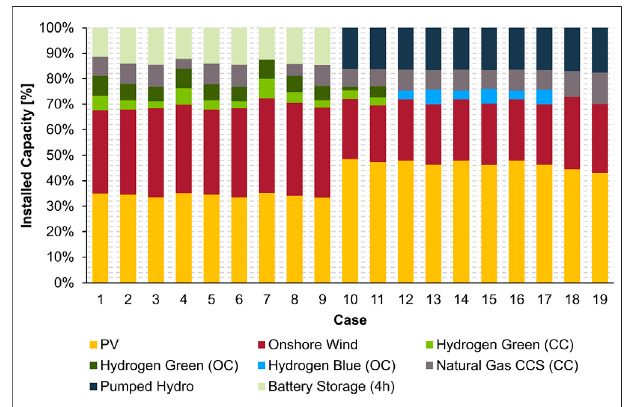
FIGURE 2 | Installed capacity and capacity mix by technology type for each case in GW.